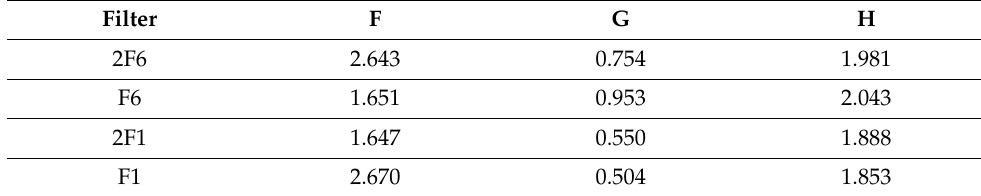
Table 5. The pressure drop equation coefficients